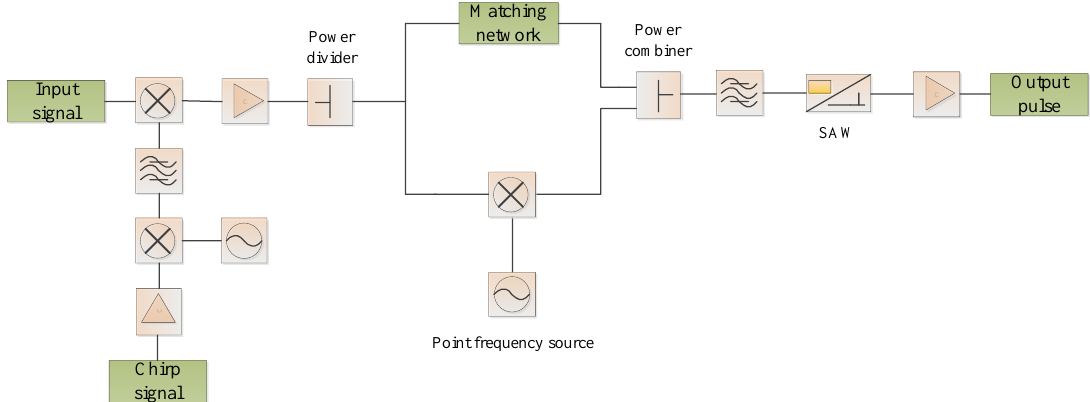
Figure 5. Frame diagram of the novel single-channel